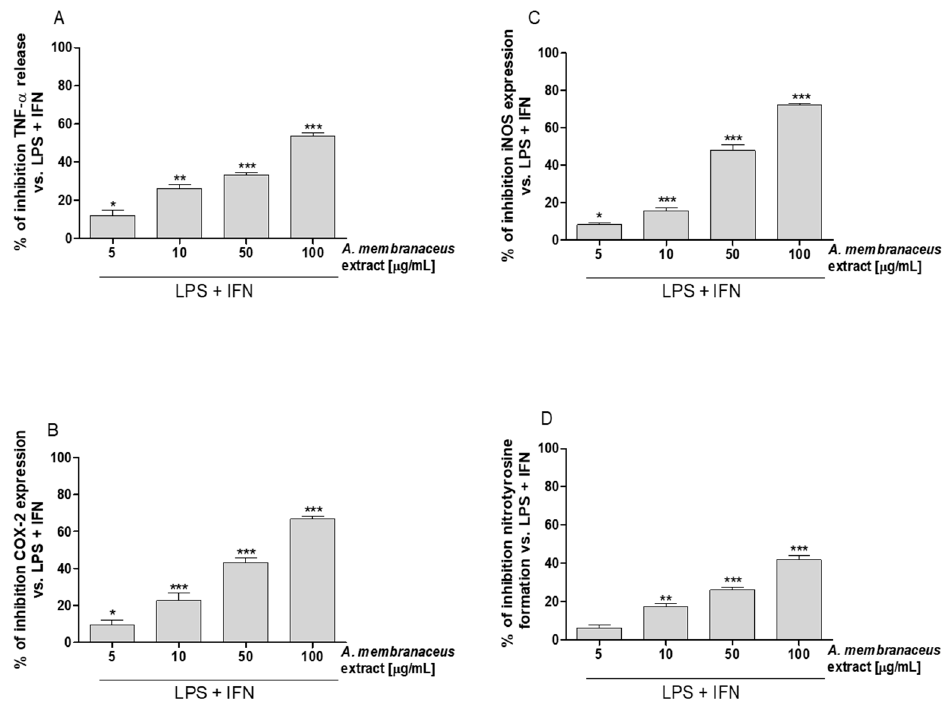
Figure 1. Inhibitory and concentration related effect of Astragalus membranaceus extract (5–100 µg/mL) in LPS + IFN-stimulated IEC-6 on ( A ) tumor necrosis factor- α (TNF α ) levels, evaluated using an ELISA, ( B ) cyclooxygenase-2 (COX-2) expression, ( C ) inducible nitric oxide synthase (iNOS) expression, and on ( D ) nitrotyrosine formation, evaluated by the cytofluorimetric technique. Data are expressed as mean ± SEM. ***, **, * indicate p < 0.001, p < 0.01 and p < 0.05 vs. LPS + IFN.